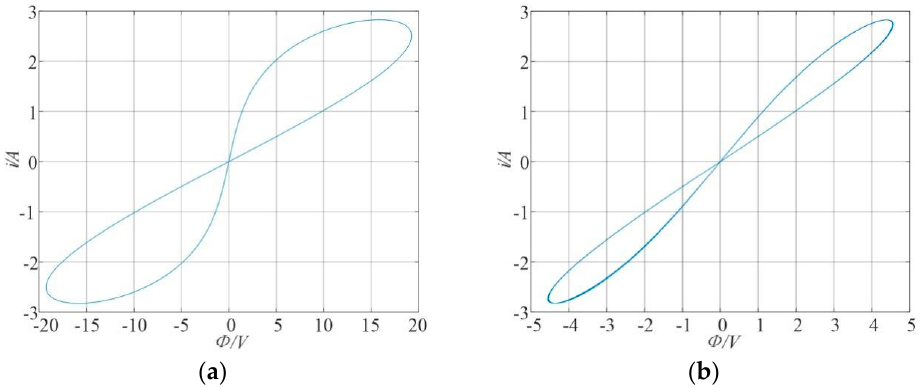
Figure 2. Characteristic curve of the smooth meminductor. ( a ) a = 1, b = 1, f = 10 Hz, ( b ) a = 1, b = 1, f = 50 Hz.